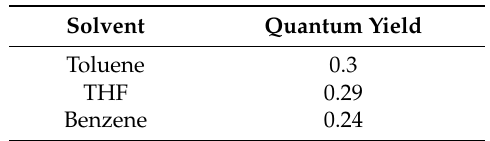
Table 1. Quantum yield of conjugated PFO-co-pX polymer in different solvents. Solvent